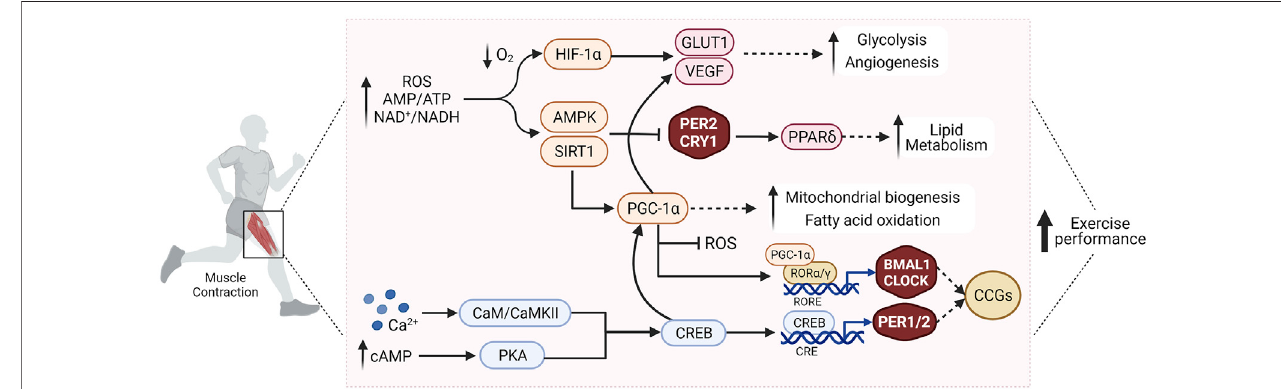
FIGURE 2 | Exercise affects the molecular clock in skeletal muscle through modulation of various interconnected signaling pathways that regulate muscle metabolismandfunction,andimproveexerciseperformance.Seetextfordetails.Abbreviations:ROS,reactiveoxygenspecies;AMP,adenosinemonophosphate;ATP, adenosinetriphosphate;NAD + ,nicotinamideadeninedinucleotide(oxidizedform);NADH,nicotinamideadeninedinucleotide(reducedform);O 2 ,oxygen;Ca 2+ ,calcium; cAMP,cyclicadenosinemonophosphate;HIF-1 α ,hypoxia-induciblefactor1 α ;PGC-1 α ,peroxisome proliferator-activatedreceptor γ coactivator1 α ;AMPK,AMP/ ADP-dependent protein kinase; PPAR δ , peroxisome proliferator-activated receptor δ ; SIRT1, Sirtuin 1; GLUT1, Glucose transporter type 1; VEGF, vascular endothelial growthfactor;CaM/CaMKII,calmodulin/Ca2+/calmodulin-dependentproteinkinaseII;PKA,proteinkinaseA;CREB,cAMPresponseelement-bindingprotein;CLOCK, CircadianLocomotorOutput CyclesKaput;BMAL1, BrainandMuscle ARNT-Like1;PER2,Period2;CRY1, cryptochrome circadianregulator1;ROR α / γ ,retinoicacid- related orphan receptor α / γ ; RORE, ROR/REV-ERB-response element; CCGs, clock controlled genes. Created with